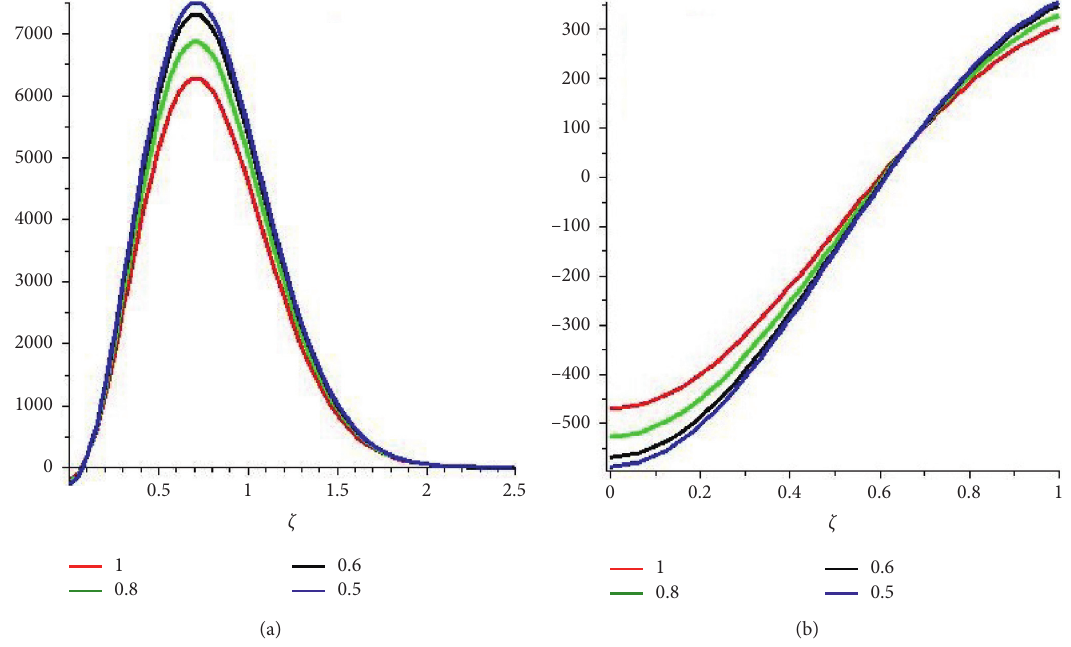
Figure 7: HPTM solutions of μ ( ζ , Ψ ) and ρ ( ζ , Ψ ) at different fractional orders c � 0 . 5 , 0 . 6 , 0 . 8 , 1 and Ψ �